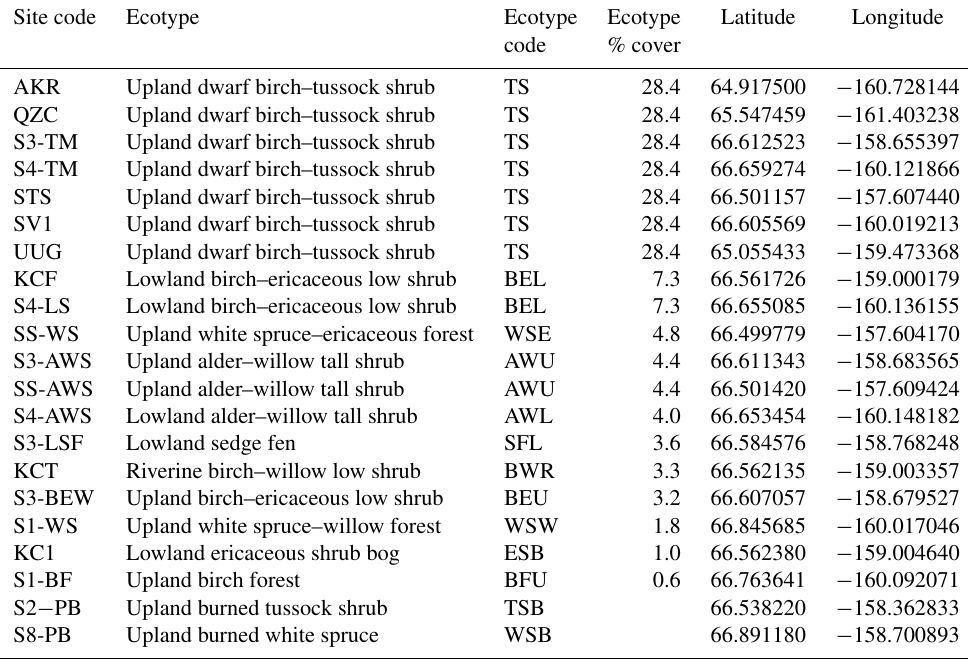
Table 1. The ecotype, ecotype areal coverage, and location of each site is shown in this table. Site codes in italics were installed in 2011 and are outside the SNWR. Site codes in bold are core